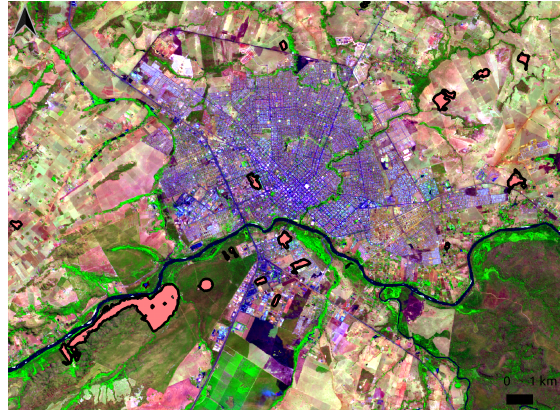
Figure 6. Reference Polygons in red used for quantitative evaluation with a sentinel-2 agricultural